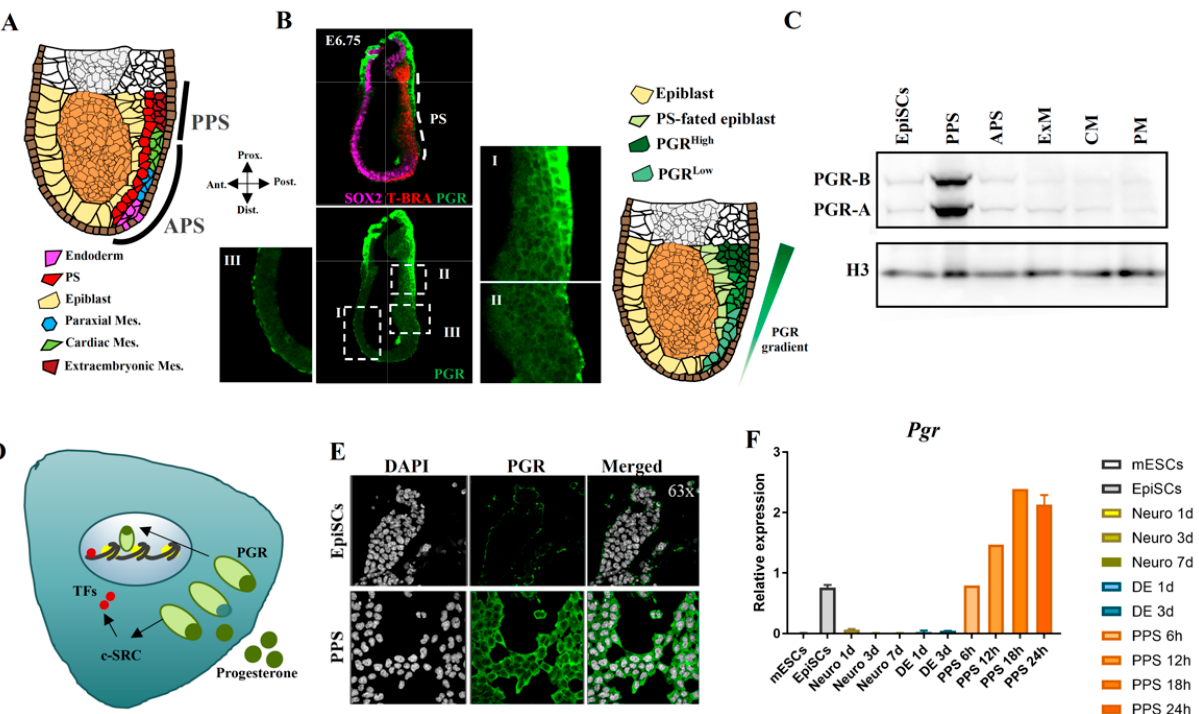
Figure 2. Pgr is expressed in primitive streak cells in vivo and in vitro. ( A ) Illustration depicting E6.5-E7.0 gastrulating embryo and indicating posterior primitive streak (PPS), anterior primitive streak (APS), and their derivatives. Endoderm (pink), primitive streak (red), epiblast (yellow), paraxial mesoderm (blue), cardiac mesoderm (green), and extraembryonic mesoderm (dark red). ( B ) Confocal images of E6.75 embryos probed with T-BRA (red), SOX2 (magenta) and PGR (green) antibodies reveal a gradient of PGR with higher levels in PPS. Panel I shows high levels of PGR in the PPS, panel II demonstrates low levels of PGR in the APS, while in panel III the complete absence of PGR in the most anterior part of the embryo. The schematic on the right depicts the PGR gradient (green) in the posterior and anterior PS. Images were taken using 40× objective. ( C ) Western blot assay confirming that PGR protein levels follow the same pattern as mRNA during mesoderm induction, with the highest protein concentration in PPS cells compared with EpiSCs, APS, ExM, CM, and PM. Histone H3 (H3) is used as loading control. ( D ) Illustration depicting the dual PGR activity as a ligand-dependent TF (nuclear localization) and modulator of signaling pathways (cytoplasmatic localization) with the previously described interaction with c-SRC [24]. ( E ) Immunofluorescence showing PGR localization in EpiSCs and PPS. In the EpiSCs, low levels of PGR are detected. In PPS, PGR protein is localized mainly in the cytoplasm with a smaller percentage present in the nucleus. Images were taken using 63× objective. ( F ) RT-qPCR analysis of Pgr expression across dif- ferent cell lineages. Pgr transcript is specifically expressed in EpiSCs and PPS. Time course induction of PPS shows the highest expression at 18 h of differentiation.